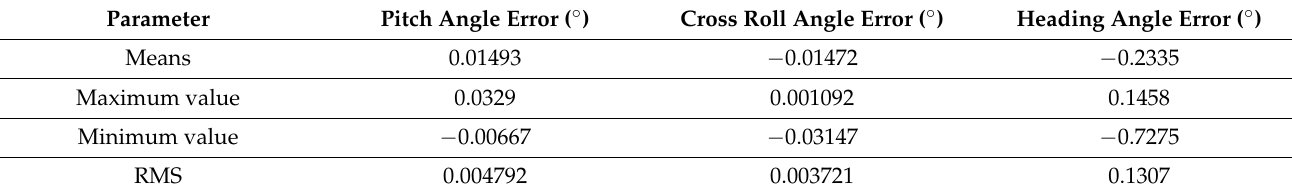
Figure 6. Static test attitude error output result graph. Table 2. Static test attitude angle error.